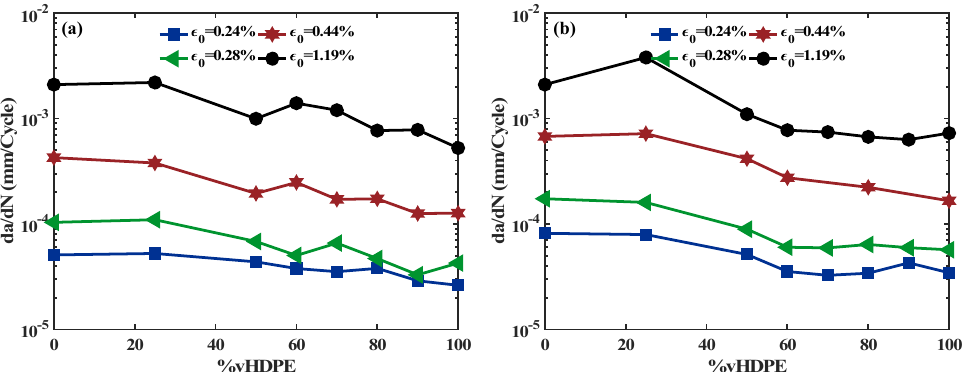
Figure 9. Crack propagation rate at different strain amplitudes as a function of the vHDPE content for both processing methods: ( a ) powder mixing and ( b ) extrusion mixing.